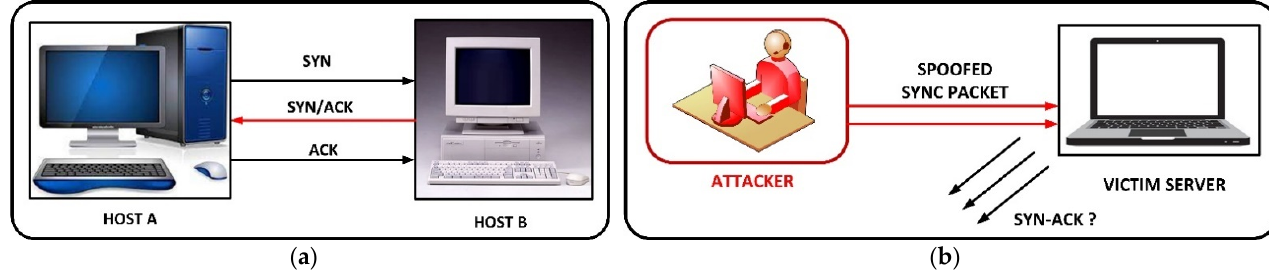
Figure 5. SYN-FLOOD attack: ( a ) three-way successful handshake and ( b ) attack mechanism.